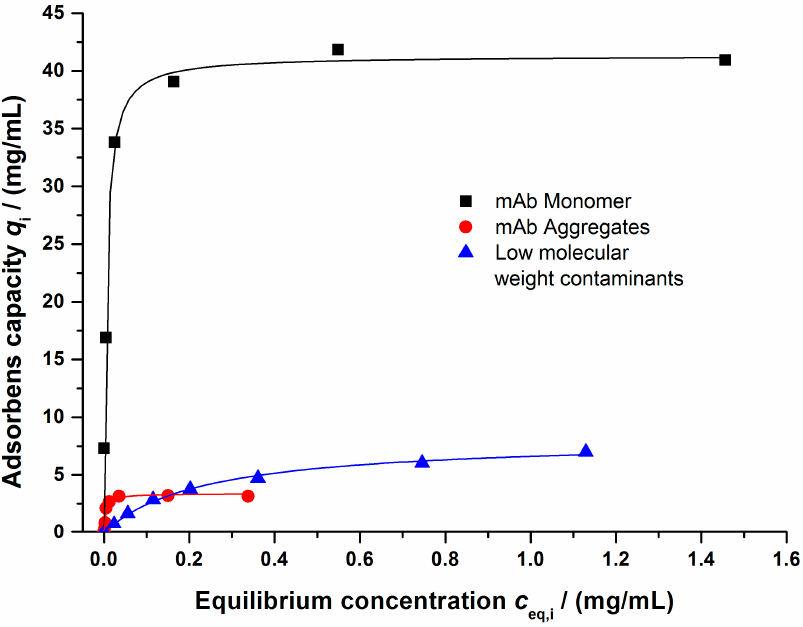
Figure 8. Representative size exclusion chromatogram of the clarified cell culture broth including an assignment of the different species present.